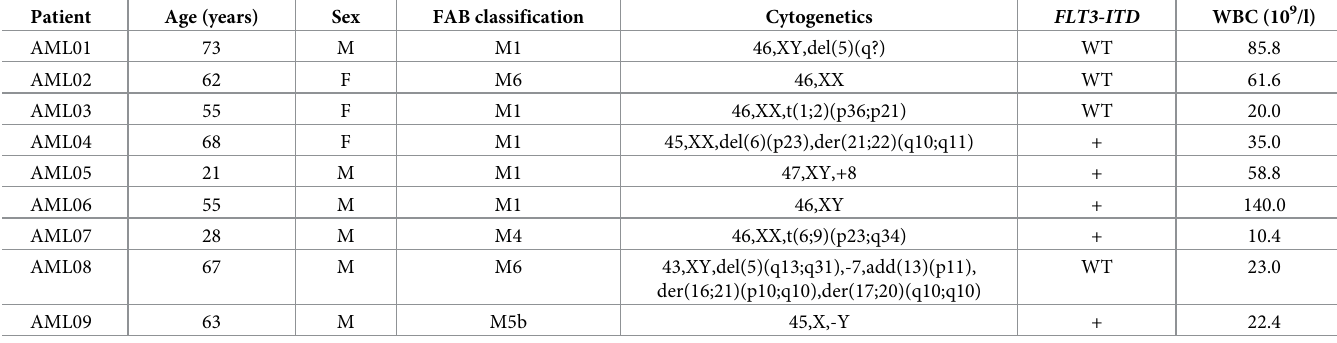
Table 1. Patient characteristics of CD25-positive